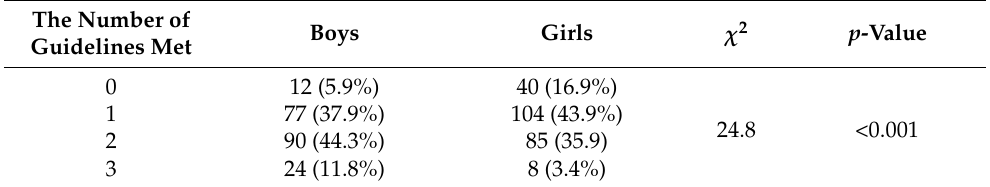
Table 2. Sex differences in compliance with 24-Hour Movement Guidelines among Chinese children and